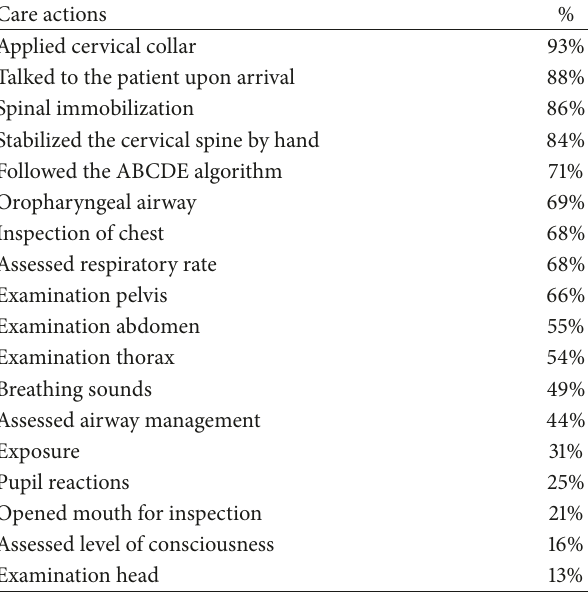
Table 2: The proportion of participants who performed specific assessments and care actions during the